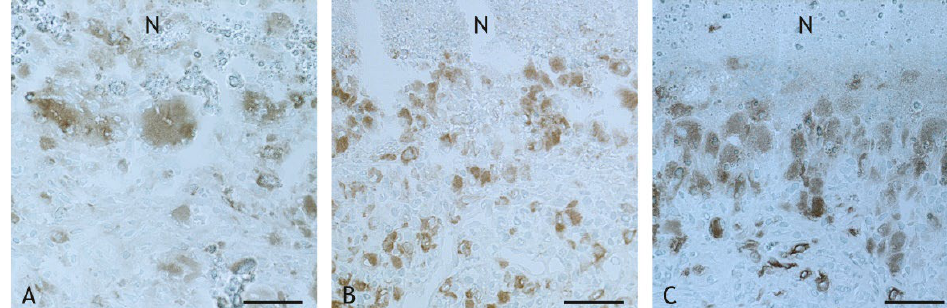
Figure 10. Epithelioid cells and MNGCs adjacent to the central necrosis (N). ( A ). BCG-induced granuloma, goat 7: epithelioid cells and MNGCs. ( B ). VPM1002-induced granuloma, goat 24: pre- dominantly epithelioid cells. ( C ). NUOG-induced granuloma, goat 5: predominantly very large epithelioid cells bordering the necrosis. IHC, CD68. Scale bars = 50 µm.